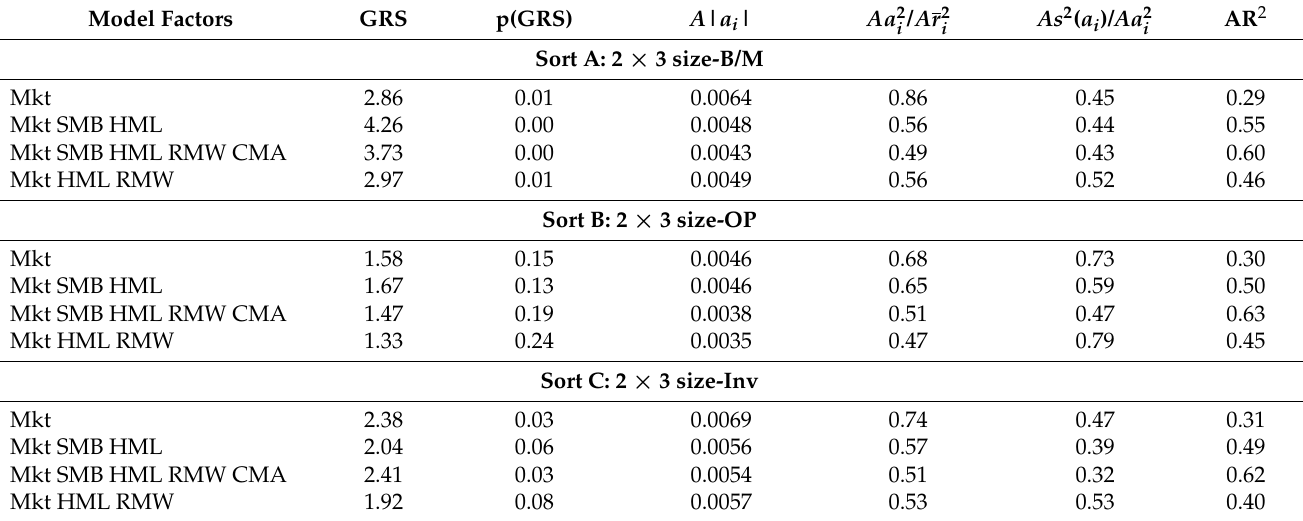
Table 5. Comparison of model performance using the GRS test and other